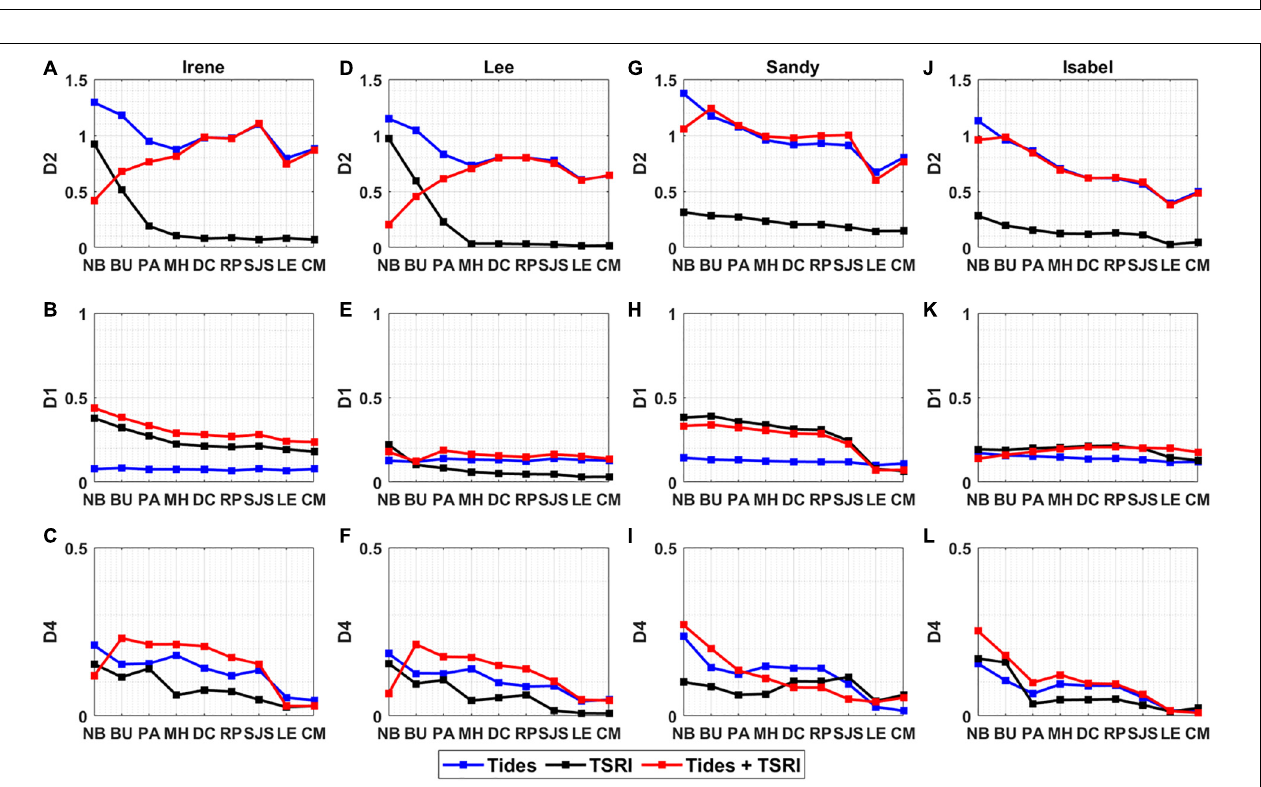
FIGURE 10 | Predicted peak amplitudes of TSRI (black) and corresponding amplitudes of tides (blue), the sum of tides and TSRI (red) at the D2, D1, and D4 bands (top to bottom) at 10 tidal gauges during Irene (A–C) , Lee (D–F) , Sandy (G–I) , and Isabel (J–L) . Note: The vertical scales for the D2, D1, and D4 bands are not the